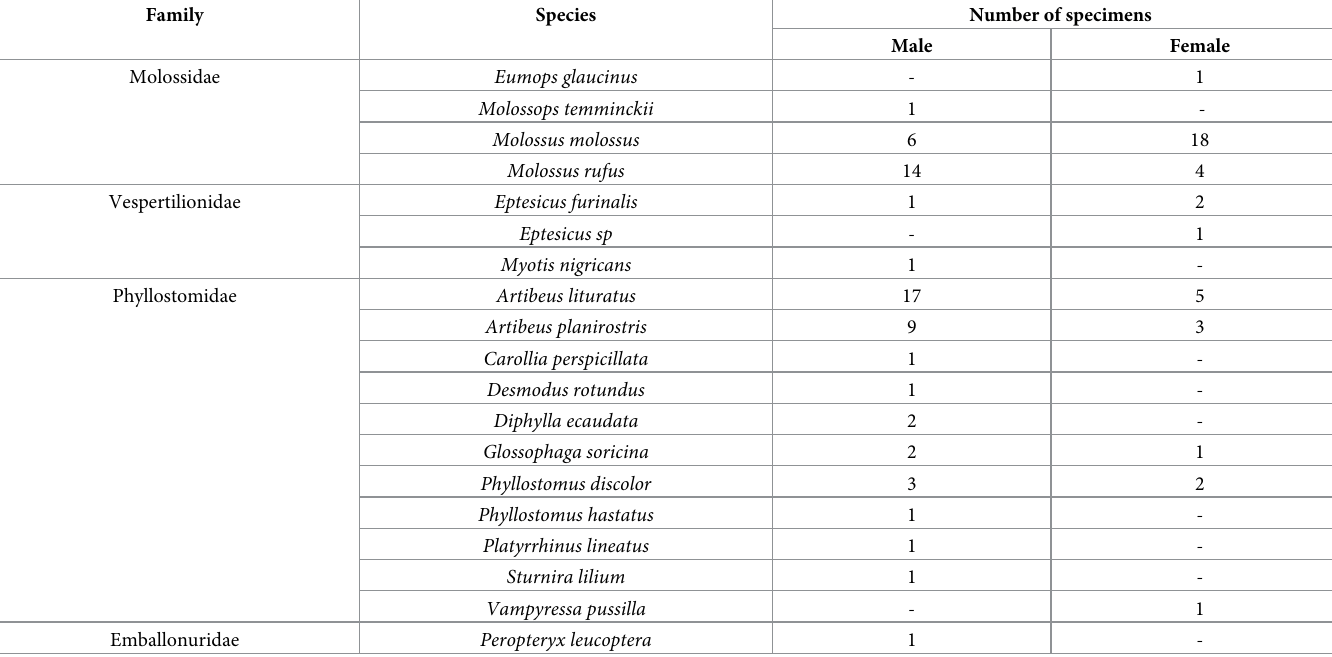
Table 2. Diversity of the species collected in relation to the sex of each specimen.